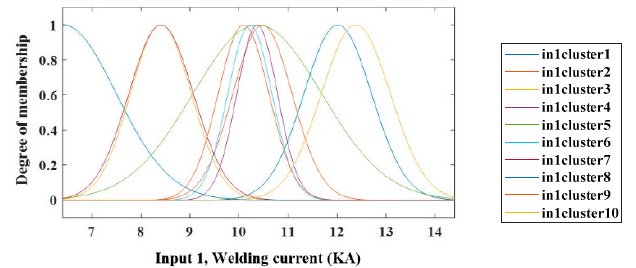
Figure 5. Optimized membership functions for the welding current.